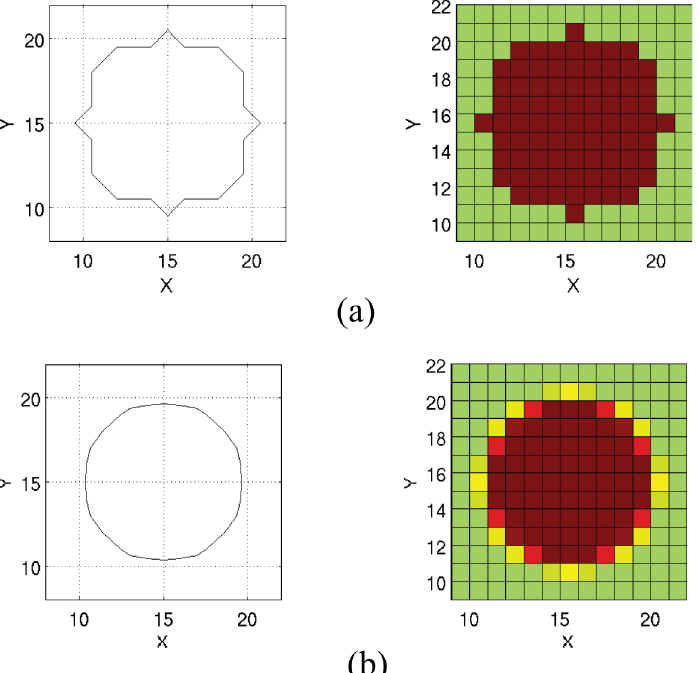
Fig 3. Illustration of the difference between the two methods of specifying the potential. Green represents a potential of 4.6 eV while red represents zero potential. The shades of orange represent weighted averages between the two. (a) The “ in or out ” method; (b) Averaging method.